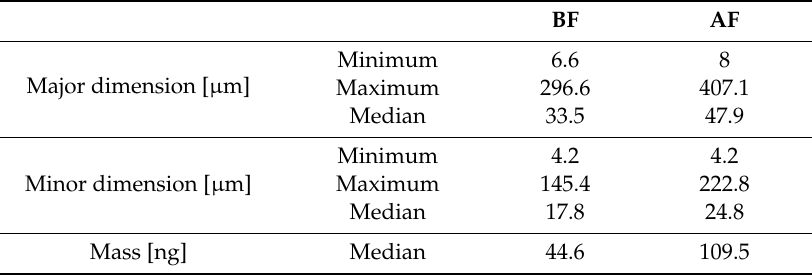
Table 3. A summary of the parameters describing the size of MPs in wastewater samples taken before (BF) and after (AF) disc filter